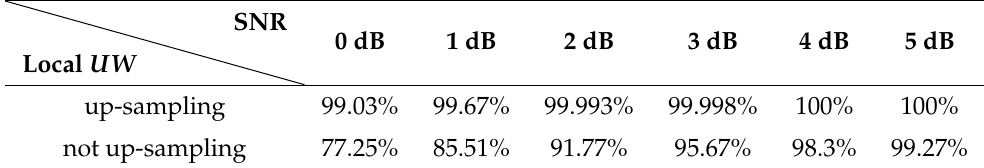
Table 4. Comparison of the detection rate between the local UW being up-sampled and not being up-sampled.